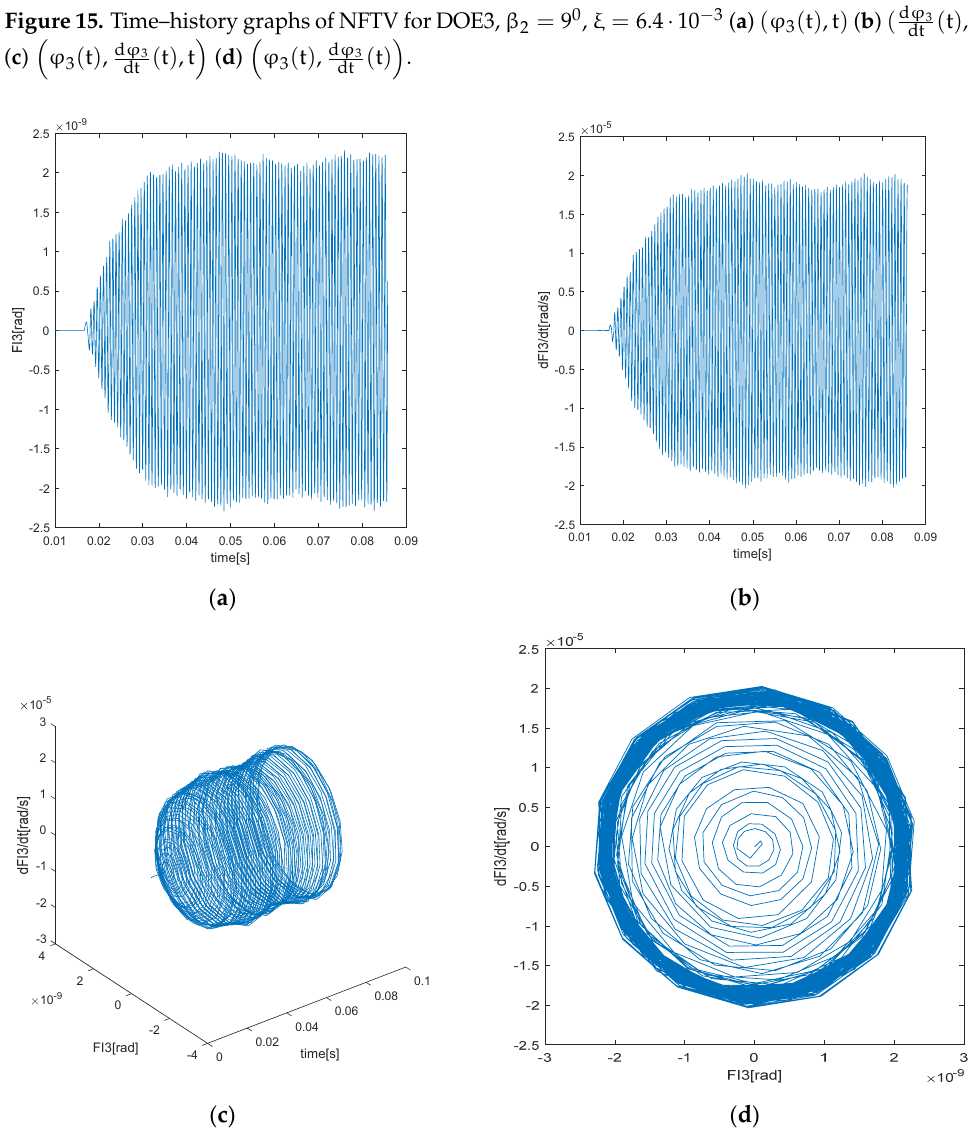
Figure 16. Time – history graphs of NFTV for DOE3, Figure 16. Time–history graphs of NFTV for DOE3, β 2 = 9 0 , ξ = 11.2 · 10 − 3 ( a ) ( ϕ 3 ( t ) ,t ) (cid:16) (cid:17) (cid:16) (cid:17) ( t ) ,t ) ( c ) ( t ) ,t ( t ) ϕ 3 ( t ) , d ϕ 3 ϕ 3 ( t ) , d ϕ 3 ( b ) ( d ϕ 3 ( d ) dt dt dt